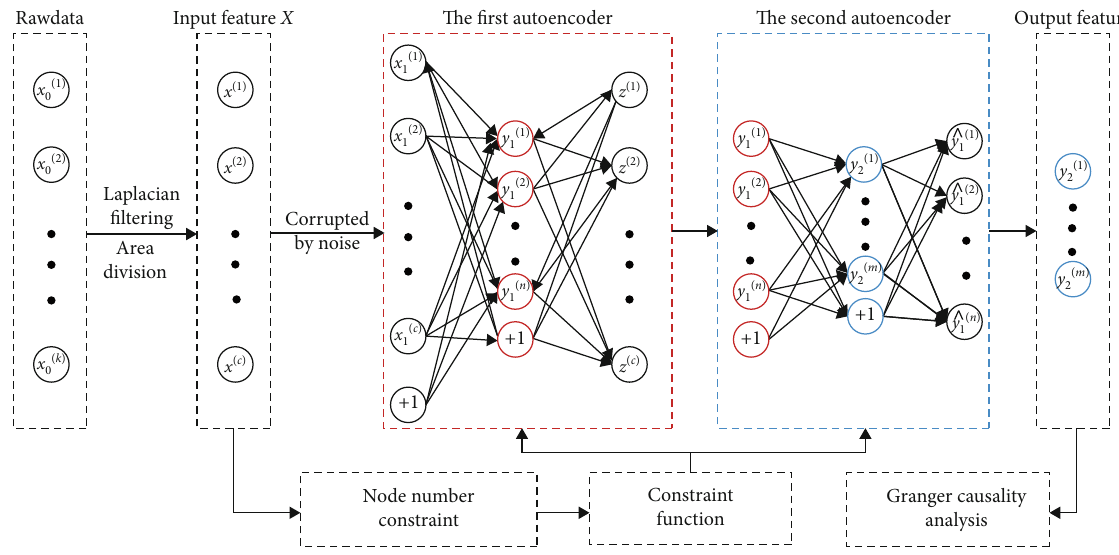
Figure 2: The fl owchart of the EEG processing method.